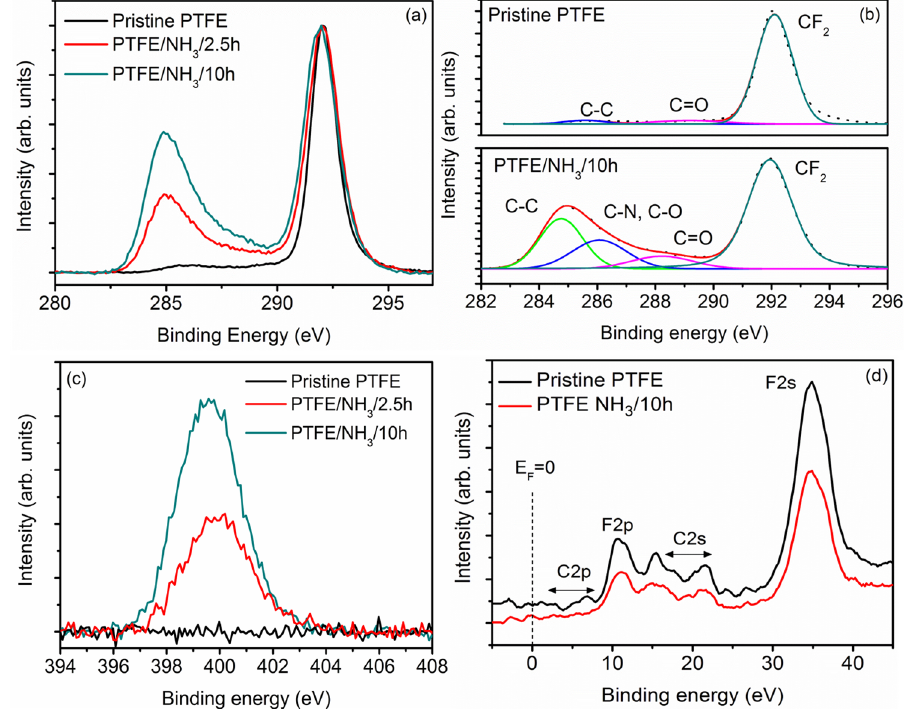
Figure 1. ( a ) High resolution C1s spectra of pristine and NH 3 plasma treated PTFE powders. ( b ) Deconvolution of C1s spectra of pristine and PTFE/NH 3 /10 h samples. ( c ) Increase in the N1s signal intensity as a function of NH 3 plasma treatment time. ( d ) XPS valence band spectra of pristine and PTFE/NH 3 /10 h